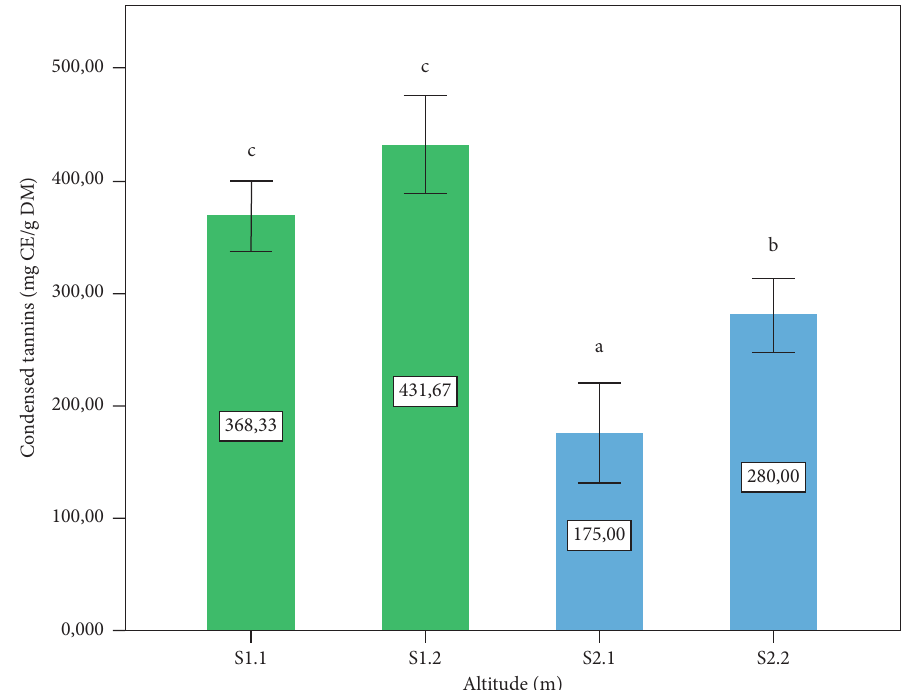
Figure 4: Condensed tannins content of the P. lentiscus L. leaves at different altitudes. Data are means of three replicates. Vertical bars represent the standard deviation of the mean. Values not sharing a common letter indicate a significant difference at p ≤ 0 . 05, based on the SNK test. CE: cyanidin equivalent. DM: dry matter. S: site, S1.1 � 1400m, S1.2 � 1120, S2.1 � 780m, S2.2 �